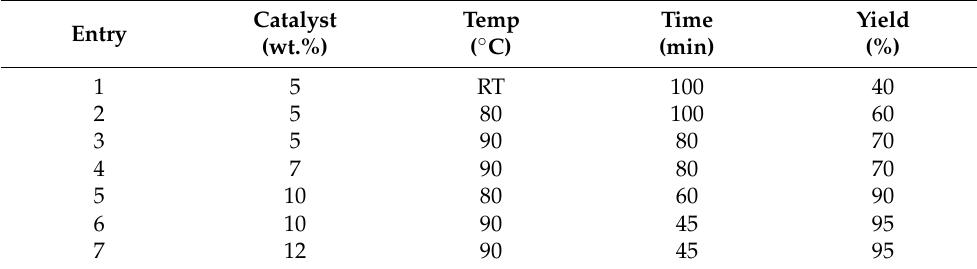
Table 2. Catalytic study of bleaching earth clay in the presence of PEG-600.